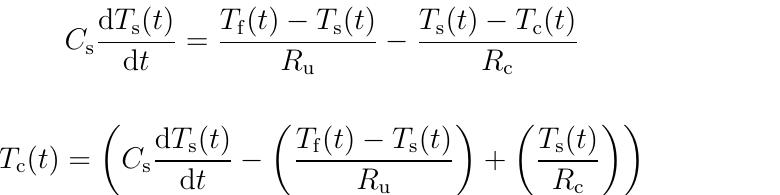
Figure 14. Temperature distribution along the radius of the cell during: ( a ) 1 I ( b ) 5 I t